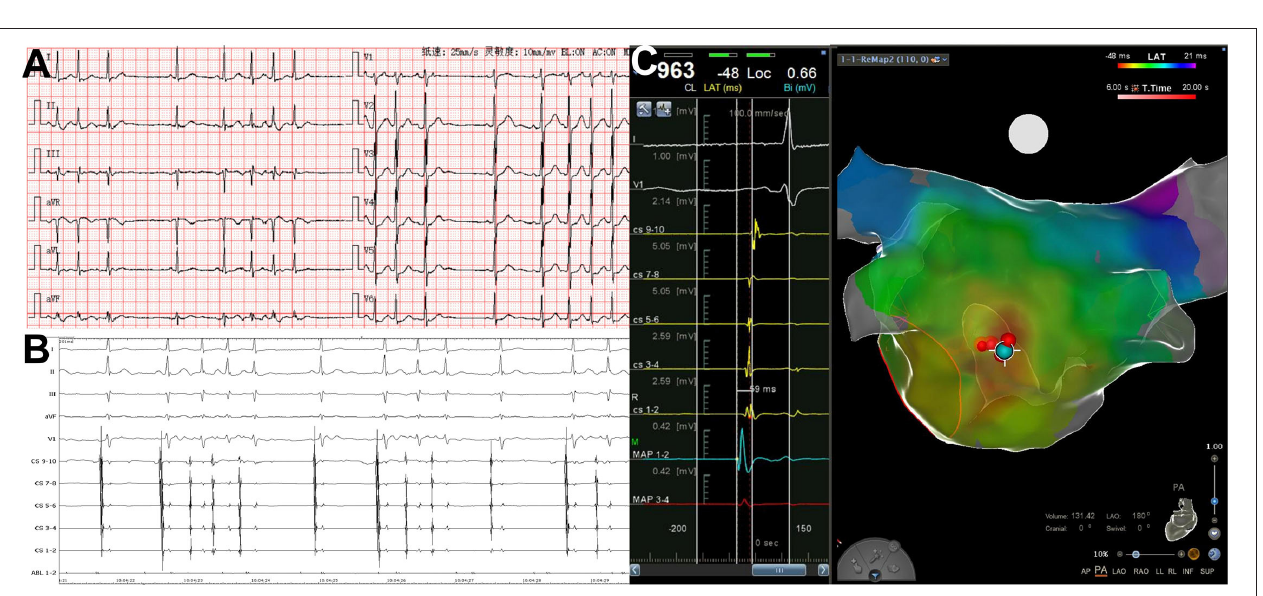
FIGURE 4 | PACs with short runs arising from left atrial posterior wall. (A) Twelve-lead surface ECG tracing during PACs. The P wave morphology is positive in precordial leads and inferior leads, flat in leads I and aVL, and negative in lead aVR. (B) Simultaneous recording of surface ECG lead I, II, III, aVF, V 1 , CS 9 − 10 ∼ CS 1 − 2 , and ABL 1 − 2 . The atrial activation in CS electrodes is almost at the same time. (C) The 3D mapping shows the origination of PACs in posterior–anterior view. The blue dot indicates the earliest activation point of PACs, and red dots indicate the ablation points. The atrial activation in the blue dot precedes surface ECG P wave in lead V 1 by 59ms. 3D, threedimensional; CS, coronary sinus; ECG, electrocardiogram; PAC, premature atrial contraction; ABL, ablation